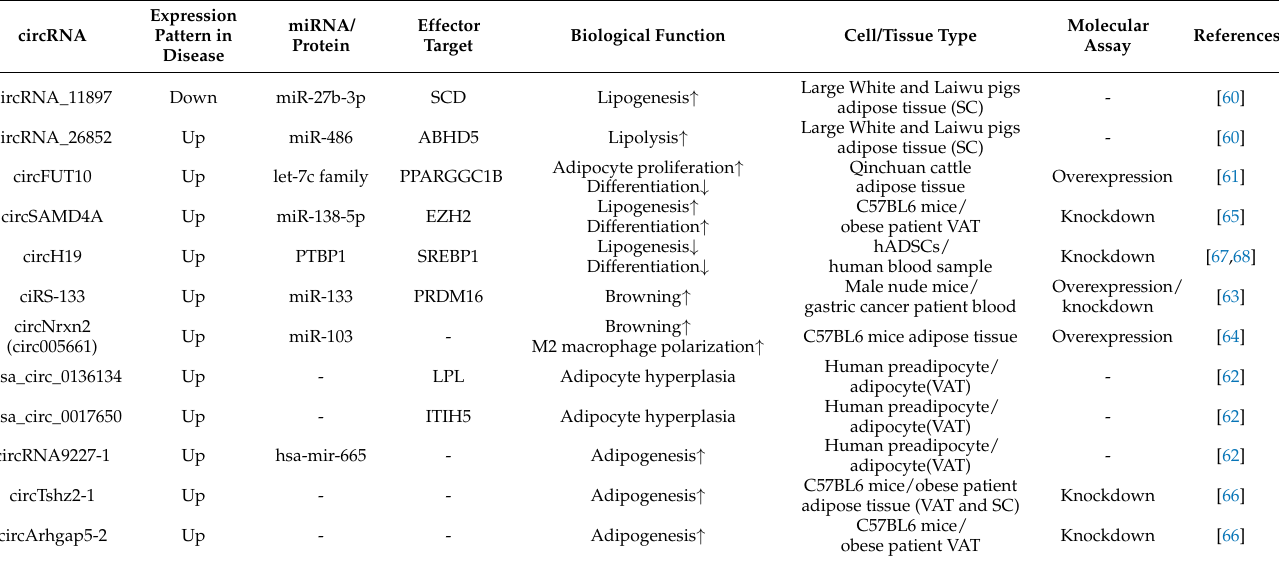
Table 1. Current roles of circular (circ)RNAs in adipocyte lipid metabolism and